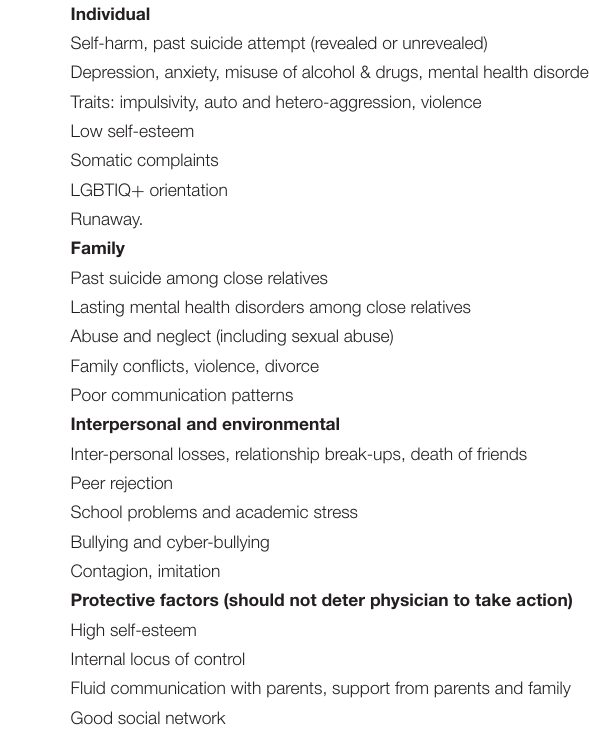
TABLE 2 | Risk and protective factors for suicidal